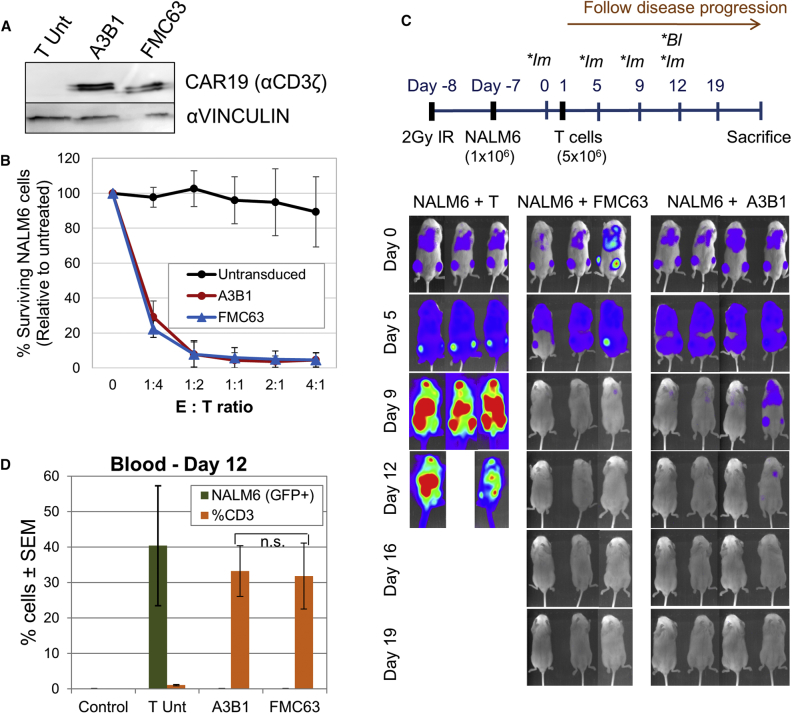
Comparison of Anti-tumor Activity of A3B1- and FMC63-based CAR T Cells(A) Detection of chimeric antigen receptor (CAR) expression by western blot. (B) Cytotoxicity assay of CART19 cells versus NALM6 cells after 4 hr of co-culture. Percent target surviving cells, relative to untreated, is shown (mean of 3 experiments ± SEM). (C) Upper panel shows a timeline of experimental design (*Im, bioluminescent image; *Bl, blood sample). Lower panels show bioluminescence images showing disease progression at different days. (D) Detection of tumor (GFP+) cells and CD3+ cells in blood by flow cytometry. Control, control mice (no tumor or T cells were injected).